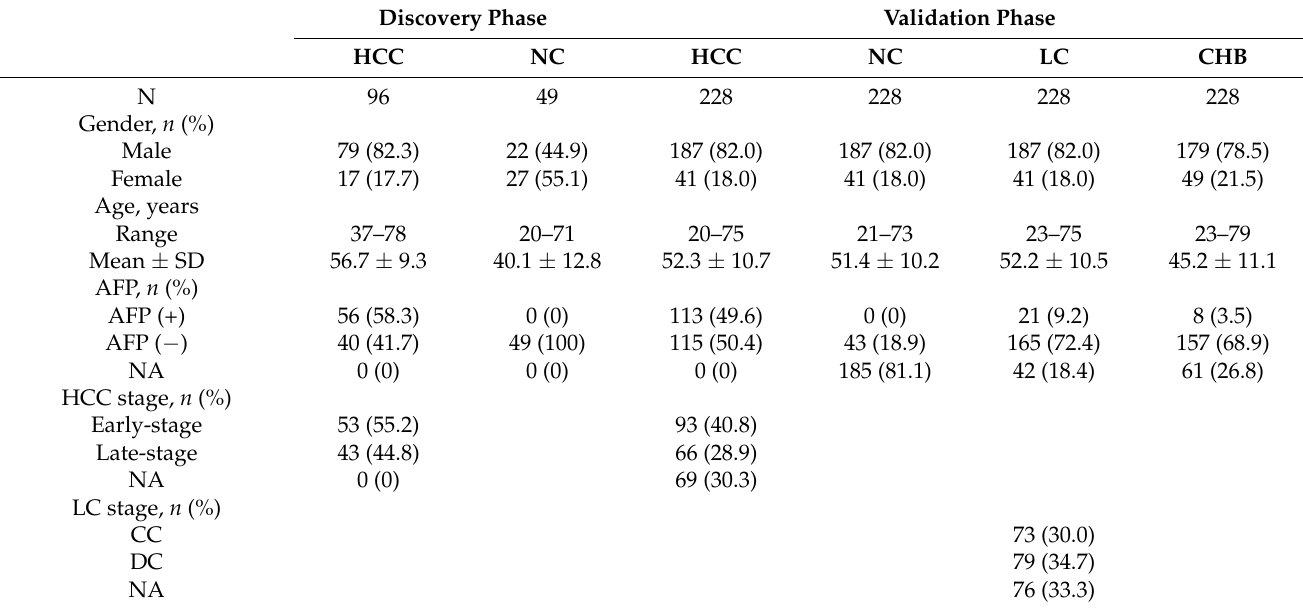
Table 1. Characteristics of